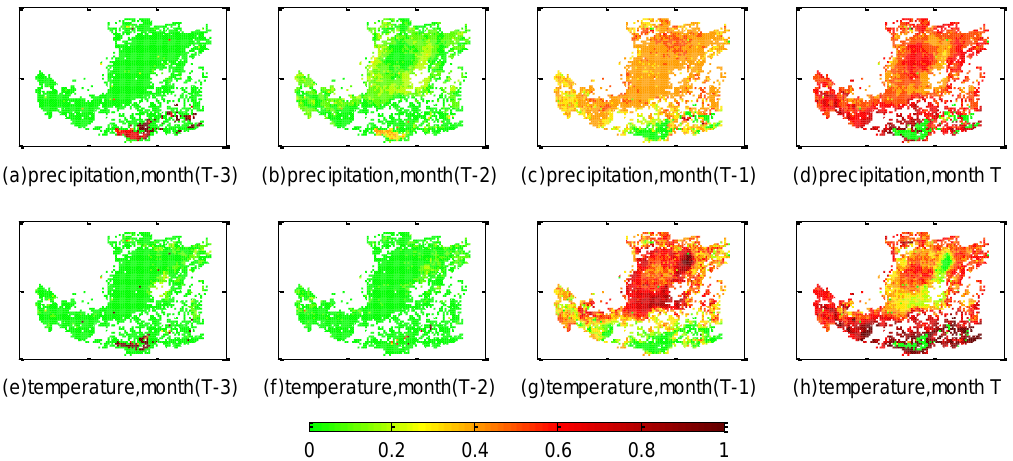
Figure 8. Weight combinations of climate impact on vegetation formulated by method 4.